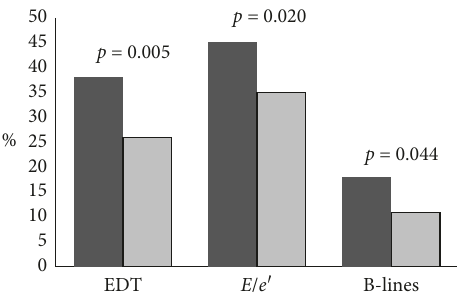
Figure 2: Frequencies of patients with an E-wave deceleration time (EDT) 150ms, a ratio of E/averaged myocardial early velocity (averaged E / e sound. Comparison between baseline (dark gray bar) and follow-up (light gray